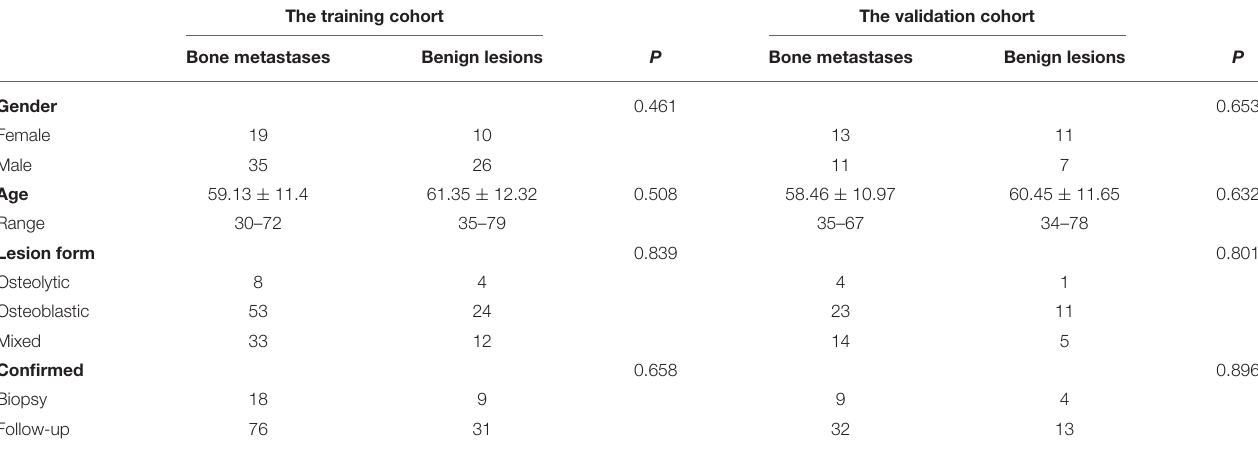
TABLE 1 | Basic information for patients in the training and validation